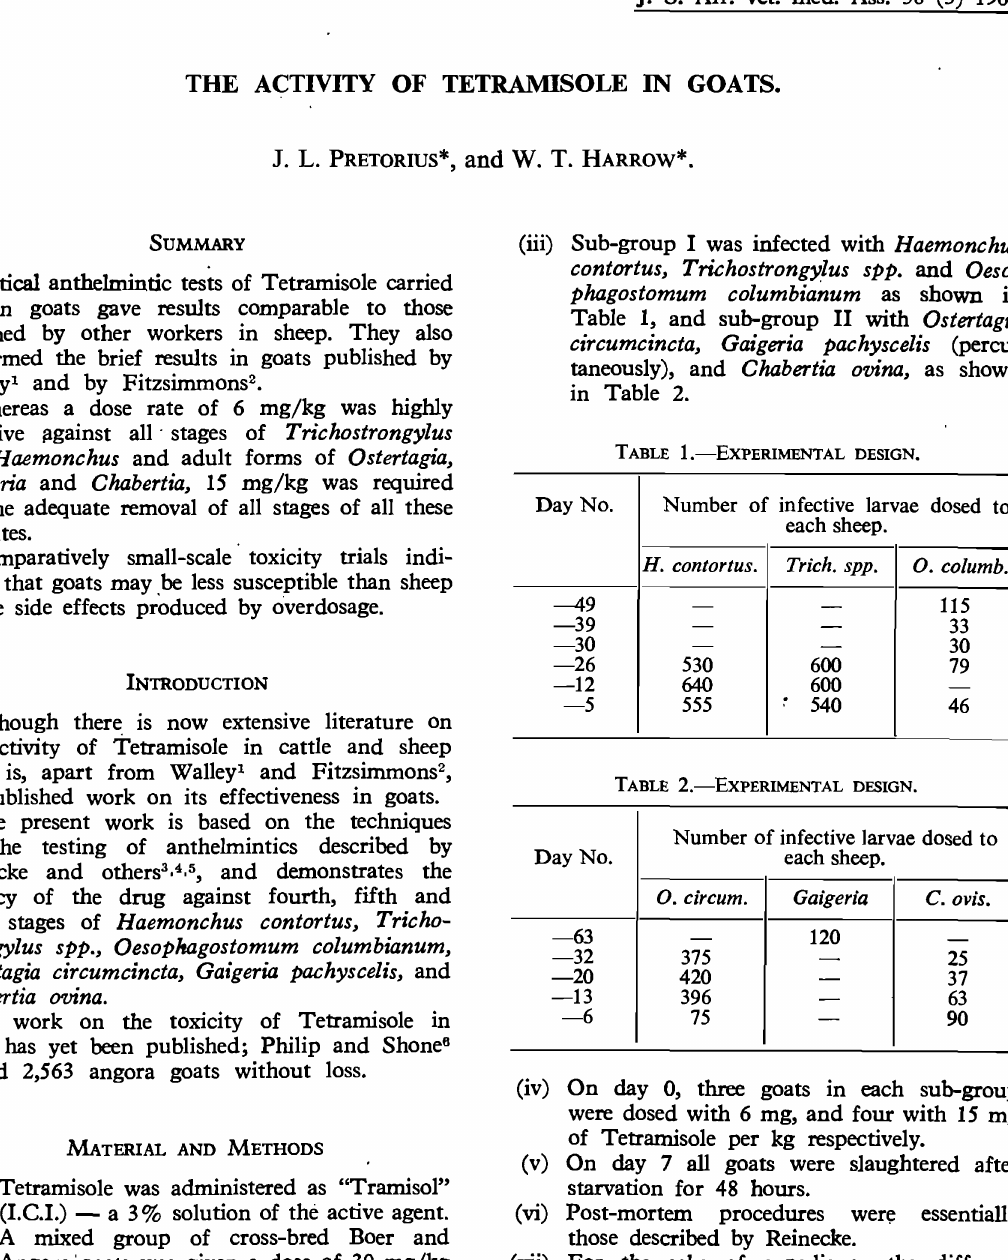
TABLE 2.-ExPERlMENTAL DESIGN. Number of infective larvae dosed to Day No. each